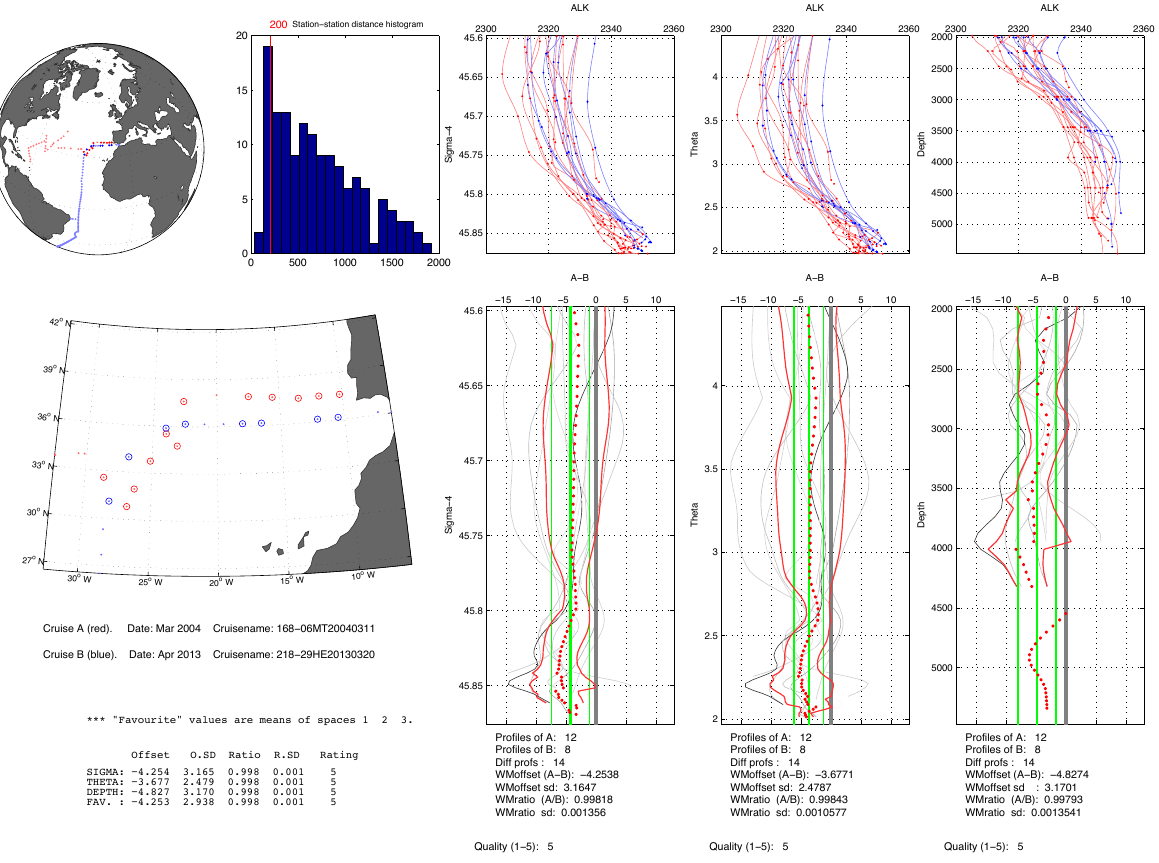
Figure B1. Summary TAlk figure for crossover stations between cruise 06MT20040311 and 29HE20130320. Note that the figure is as it appears in the Adjustment Table and from before final cruise numbers were assigned; hence, the cruise numbers given in this figure, 168 and 218, are not the GLODAPv2 cruise numbers that are used for our data product. The relative difference here is approximately 4µmolkg − 1 , with the red ( Meteor ; 06MT) cruise seeming to have lower abyssal values than the blue ( Hesperides ; 29HE). The 06MT data were adjusted by + 4µmolkg − 1 for the final product